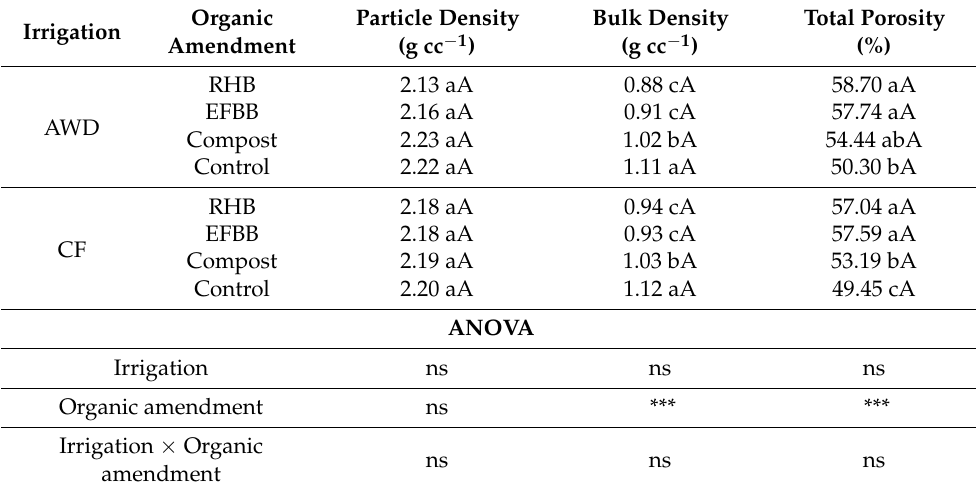
Table 6. Effect of organic amendments and irrigation management on physical properties of the paddy